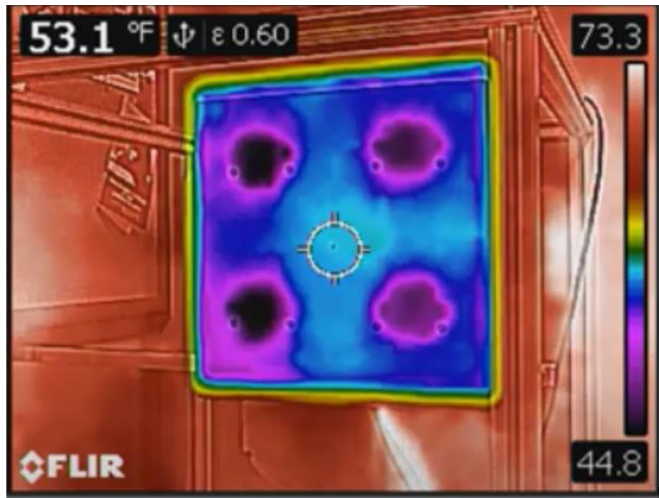
Figure 7: The transient temperature profile of the four-TEC condensation plate configuration by thermal